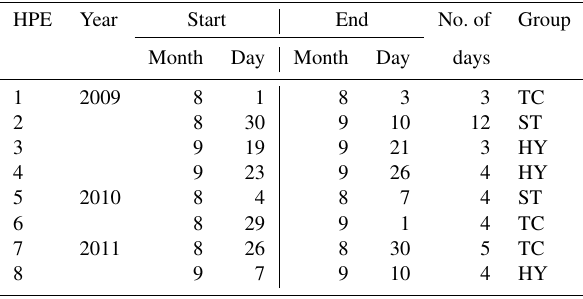
Table 1. HPEs for the study period. Eight HPEs were identified and classified into three HPE groups: stagnant (ST), tropical cyclone (TC) and hybrid